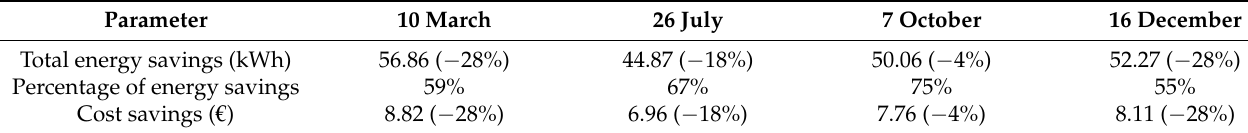
Table 7. Daily savings for scenario